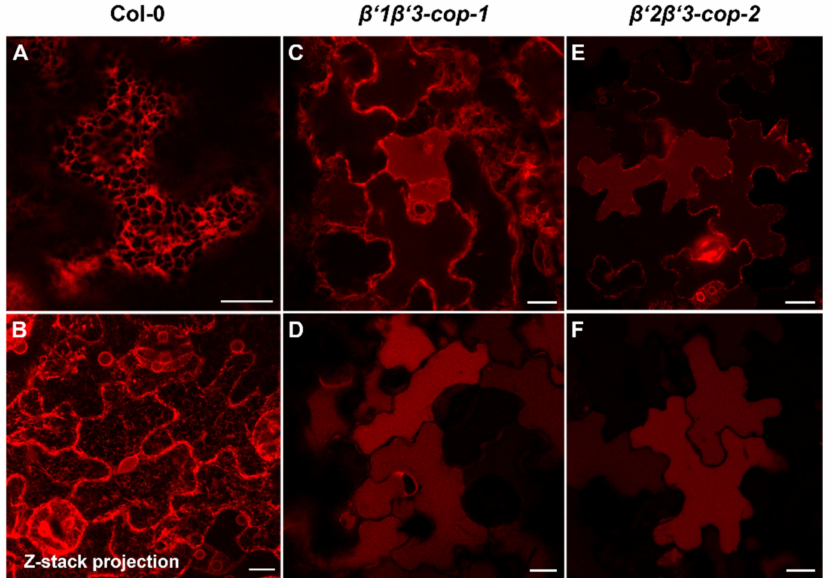
Figure 6. β ’-cop double mutants show abnormal distribution of RFP–p24 δ 5, a COPI dilysine cargo. Confocal laser scanning microscopy of epidermal cells of 4.5-day-old cotyledons. All images